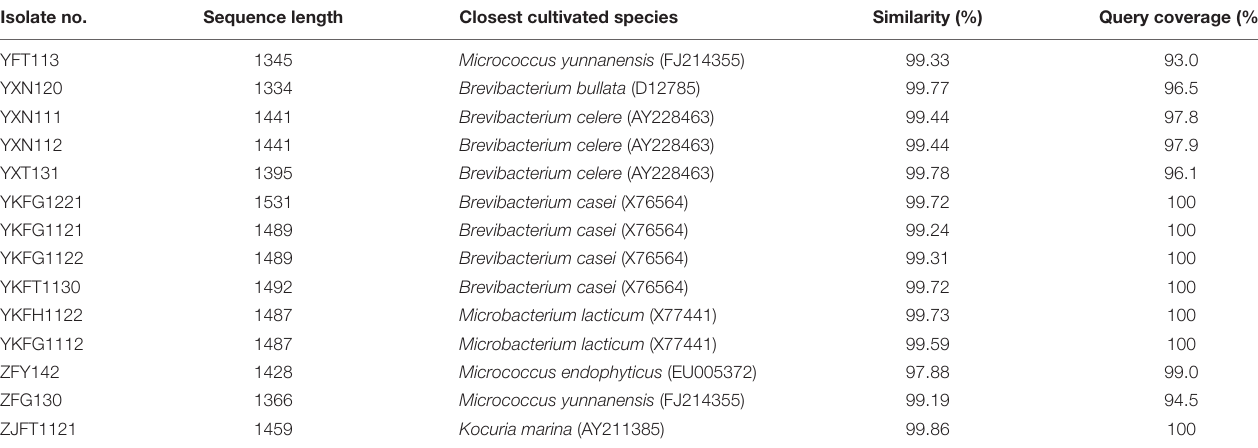
TABLE 4 | Endophytic actinobacteria isolated from Zijuan and Yunkang-10, and similarity values for 16S rRNA gene sequences. Isolate no.